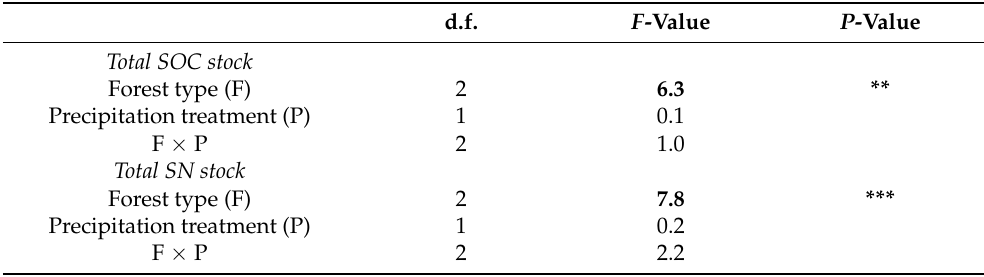
Table 4. Effects of forest type ( P. halepensis , Q. ilex and Q. pubescens ), precipitation treatment (natural or amplified drought) and their interactions on total SOC and SN stocks within the first 10 cm soil depth. F -values values and associated P -values (** for P < 0.01 and *** for P < 0.001) are indicated. Significant values are indicated in